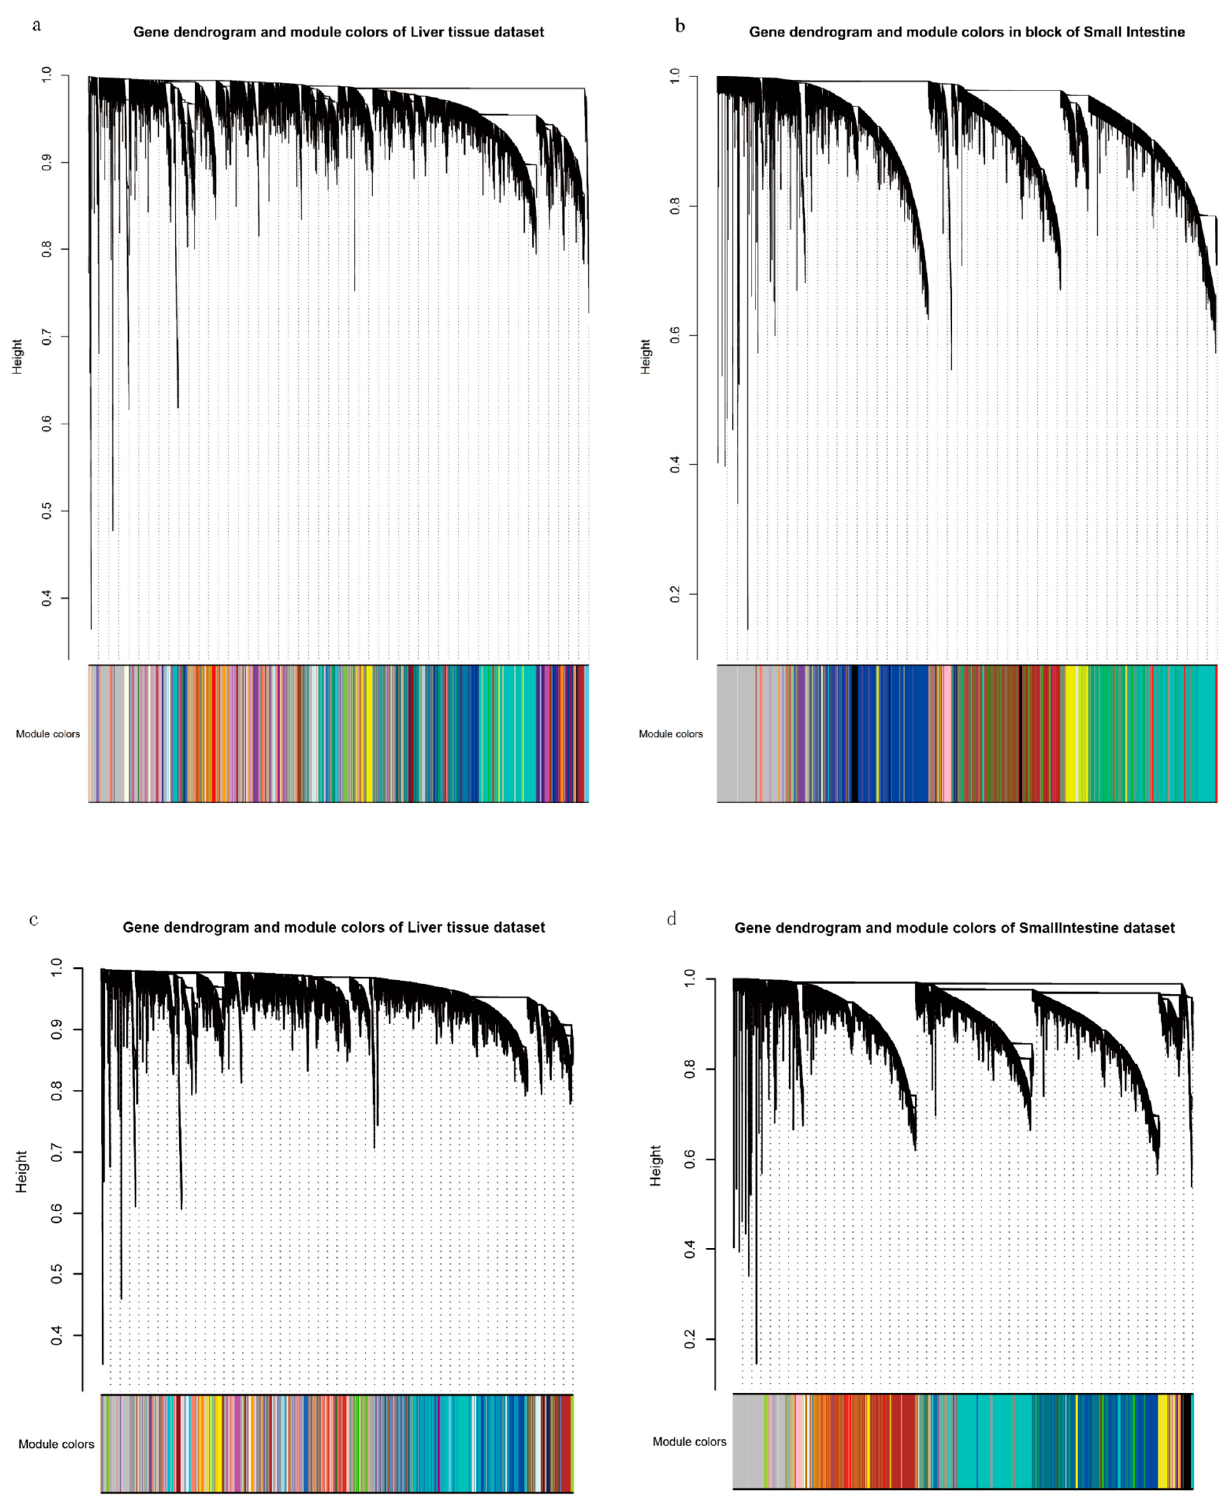
Figure 2. Gene clustering tree and module identification. The top halves of the four plots represent the gene clustering tree constructed based on topological overlap, and the height on the y-axis represents distance between modules; the higher the height value, the less likely it is that the two modules are co-expressed. The lower half of each of the four plots represents the gene modules, and each colored row represents a color-coded module that contains a group of highly connected